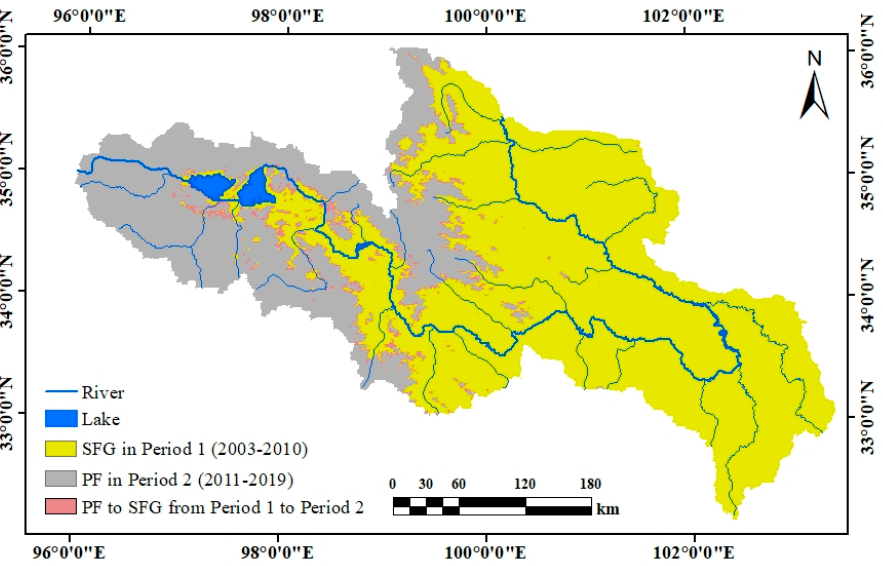
Figure 5. Changes in the distribution of frozen soil types from Period 1 (2003–2010) to Period 2 (2011–2019). PF means permafrost and SFG means seasonally-frozen ground.